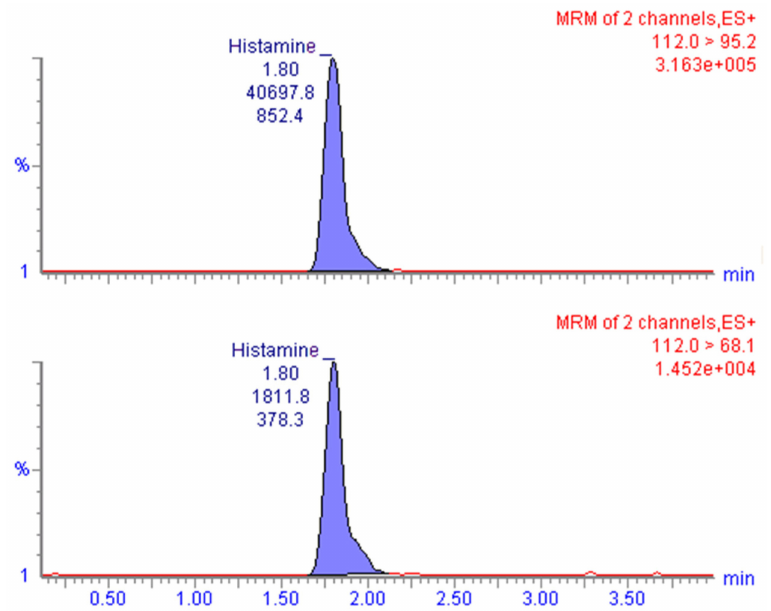
Figure 1. Chromatogram obtained after LC-MS/MS analysis of a naturally contaminated sample at 28.7 mg/kg level representing the quantitation ( m / z 112.0 > 95.2, upper) and confirmation ( m / z 112.0 > 68.1, lower) MRM